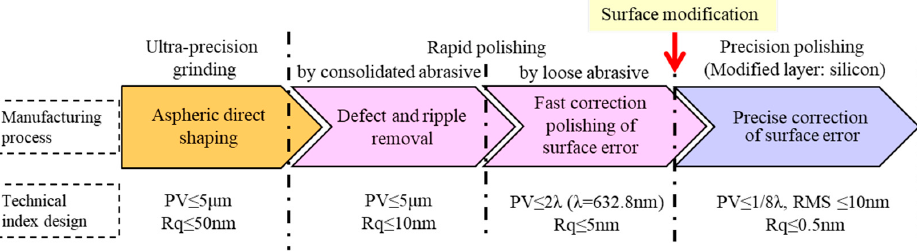
Figure 1. Design of an ultra-precision manufacturing process for large-aperture silicon carbide aspheric mirrors.